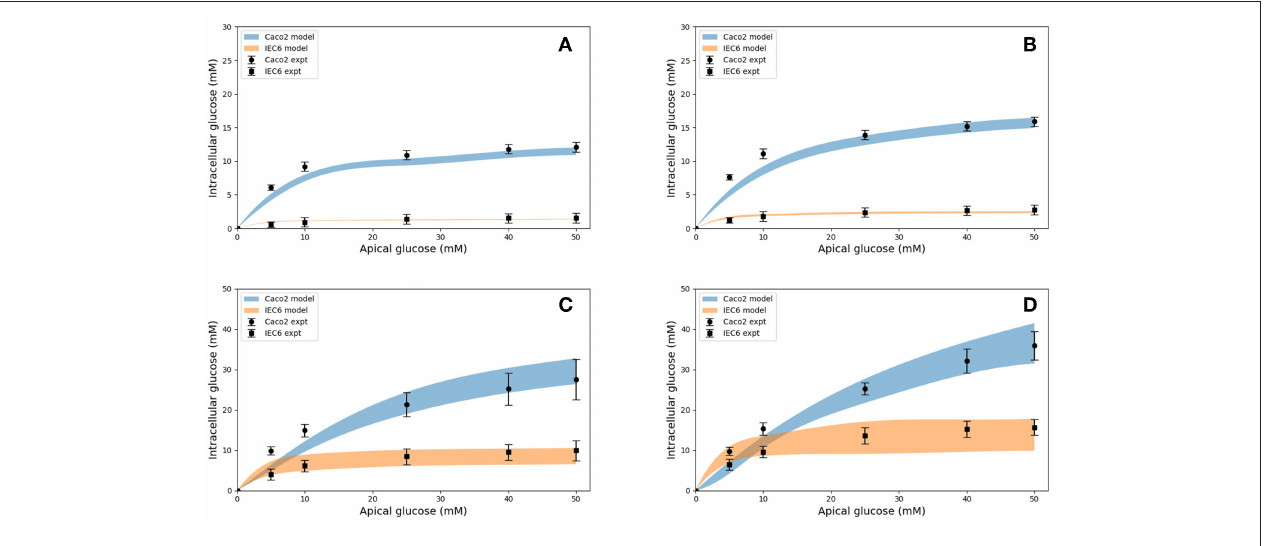
FIGURE 5 | Intracellular glucose concentrations for a range of extracellular glucose concentrations in Caco2 and IEC6 cells and exposure times ( A : 30s, B : 60s, C : 300s, D : 600 s). Experimental data points and error bars were digitally extracted from Zheng et al. (2012). Strips for the model predictions represent the range of values generated by setting V b = mV c , m = 0.1,1,10,100, ∞ .